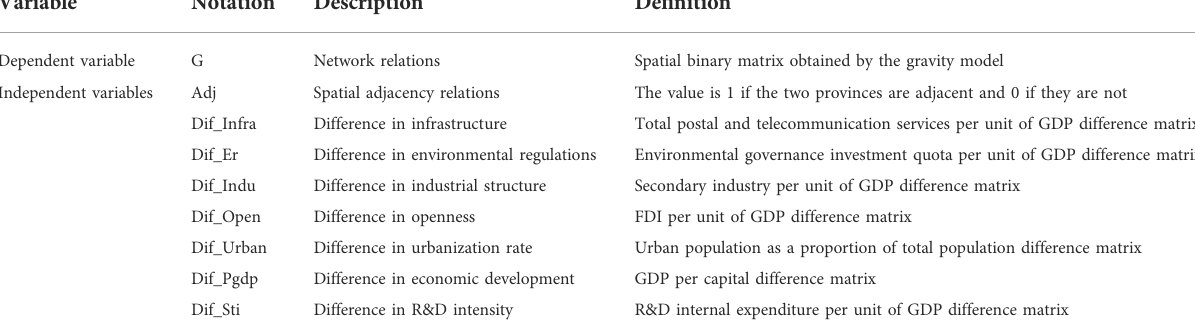
TABLE 1 Variables and data de fi nitions.